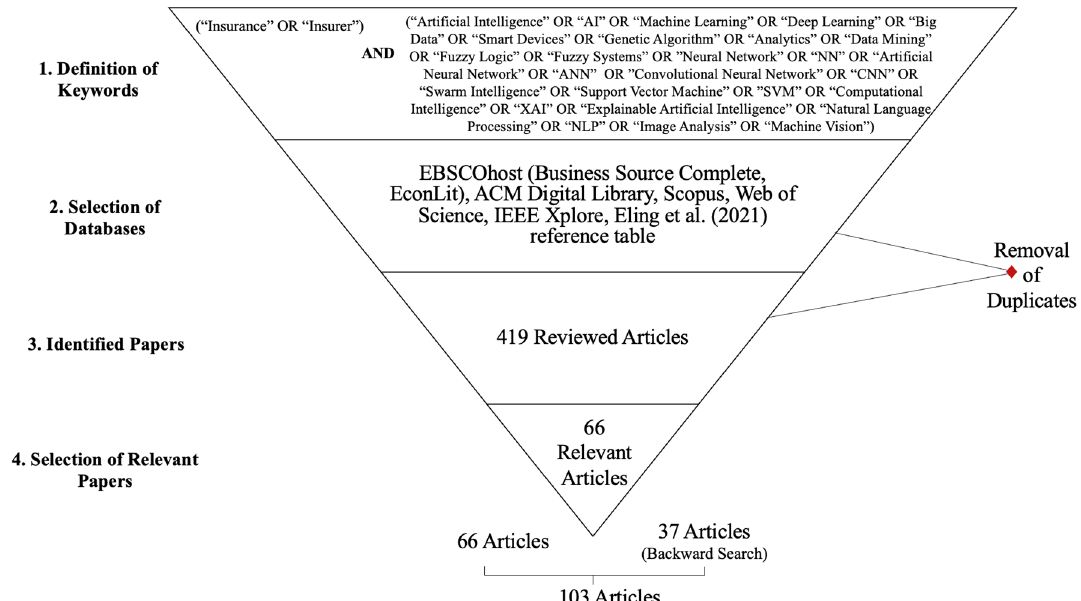
Figure 1. Literature Search Process. Backward Searching includes the assessment of the references in each of the 103 relevant articles for additional articles of relevance to the current review. Note: Eling et al.